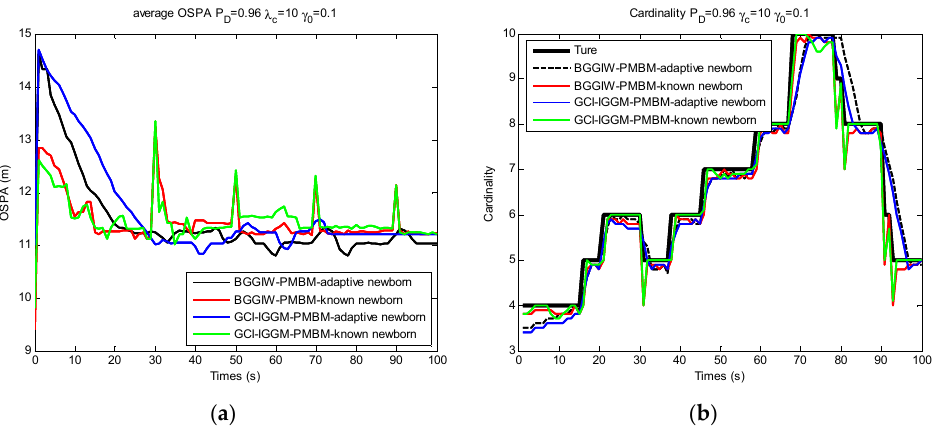
Figure 5. With an increase in the detection probability, the tracking performance improved. The cardinality estimations of GCI–IGGM–PMBM followed the true trajectory with relatively high accuracy.